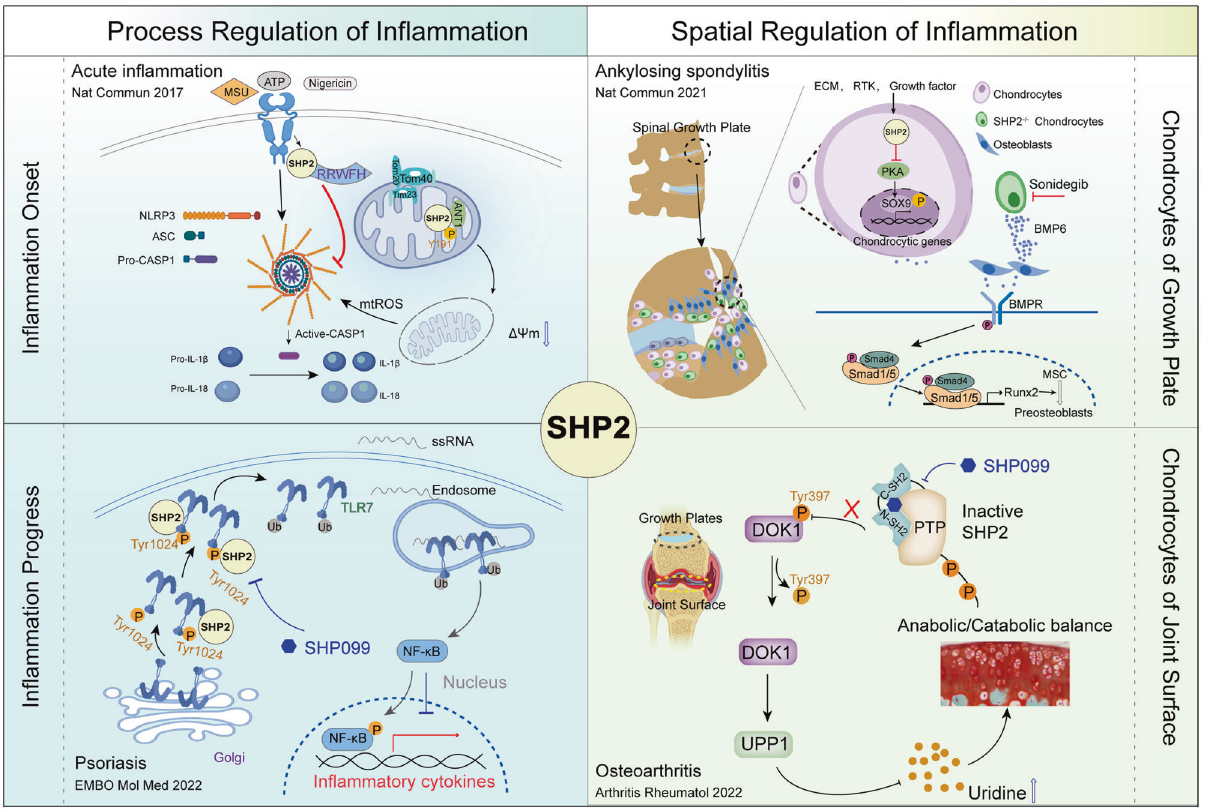
Fig. 7 The process and spatial regulation of the in fl ammation response by SHP2. In the left panel, SHP2 responds quickly and translocates into the mitochondria to interact with ANT1 which inhibits the decrease in mitochondrial membrane potential and mtROS production at the in fl ammation onset. The early function of SHP2 in acute in fl ammation prevents the activation of NLRP3 and cytokine release. With the progression of in fl ammation, SHP2 promotes the TLR7/Endosome/NF- κ B-mediated in fl ammation of psoriasis. Targeting SHP2 with SHP099 could relieve the progression of psoriasis. In the right panel, SHP2 is essential for the gene expression of chondrocytes of the growth plate. Decreased expression of SHP2 in growth plate chondrocytes results in overexpression of BMP6 and facilitates ankylosing spondylitis-like symptoms, while interruption with sonidegib prevents these symptoms. In the chondrocytes of the joint surface, an increased SHP2 expression disrupts the anabolic/catabolic balance and induces osteoarthritis by phosphorylation of its target protein DOK1 at Tyr397, which is associated with UPP1-uridine production. Targeting SHP2 with SHP099 may be a therapeutic strategy for